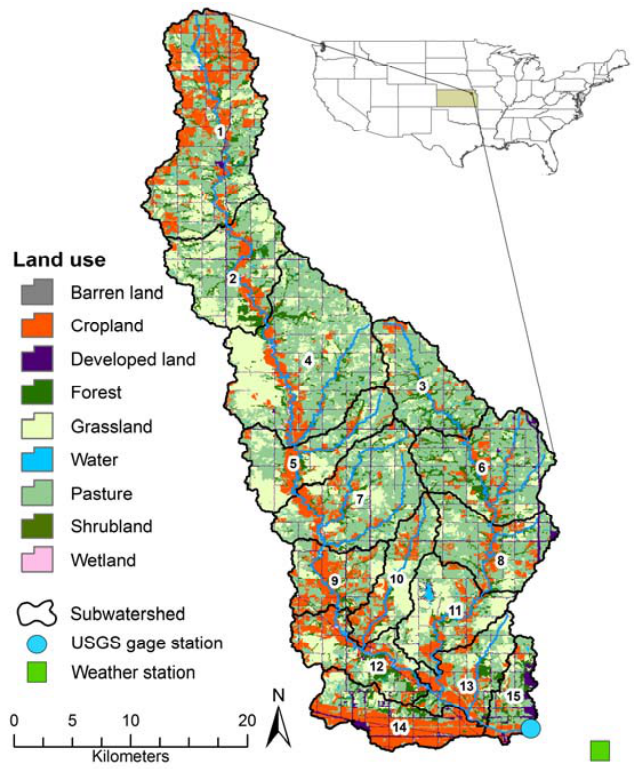
Figure 1 . Soldier Creek watershed in northeast Kansas, USA, showing watershed boundaries, subwatersheds, weather station, and streamflow gaging station.